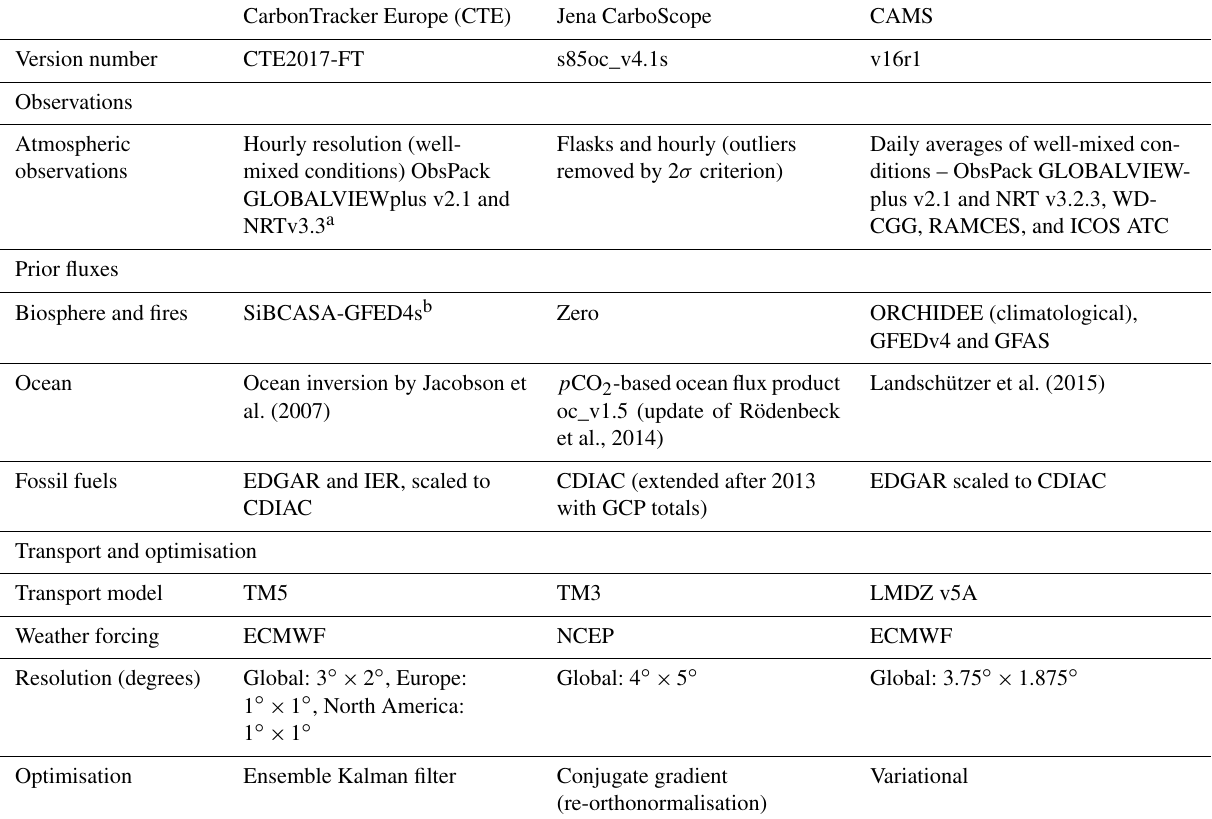
Table A3. Comparison of the inversion setup and input fields for the atmospheric inversions. Atmospheric inversions see the full CO 2 fluxes, including the anthropogenic and pre-industrial fluxes. Hence, they need to be adjusted for the pre-industrial flux of CO 2 from the land to the ocean that is part of the natural carbon cycle before they can be compared with S OCEAN and S LAND from process models. See Table 4 for